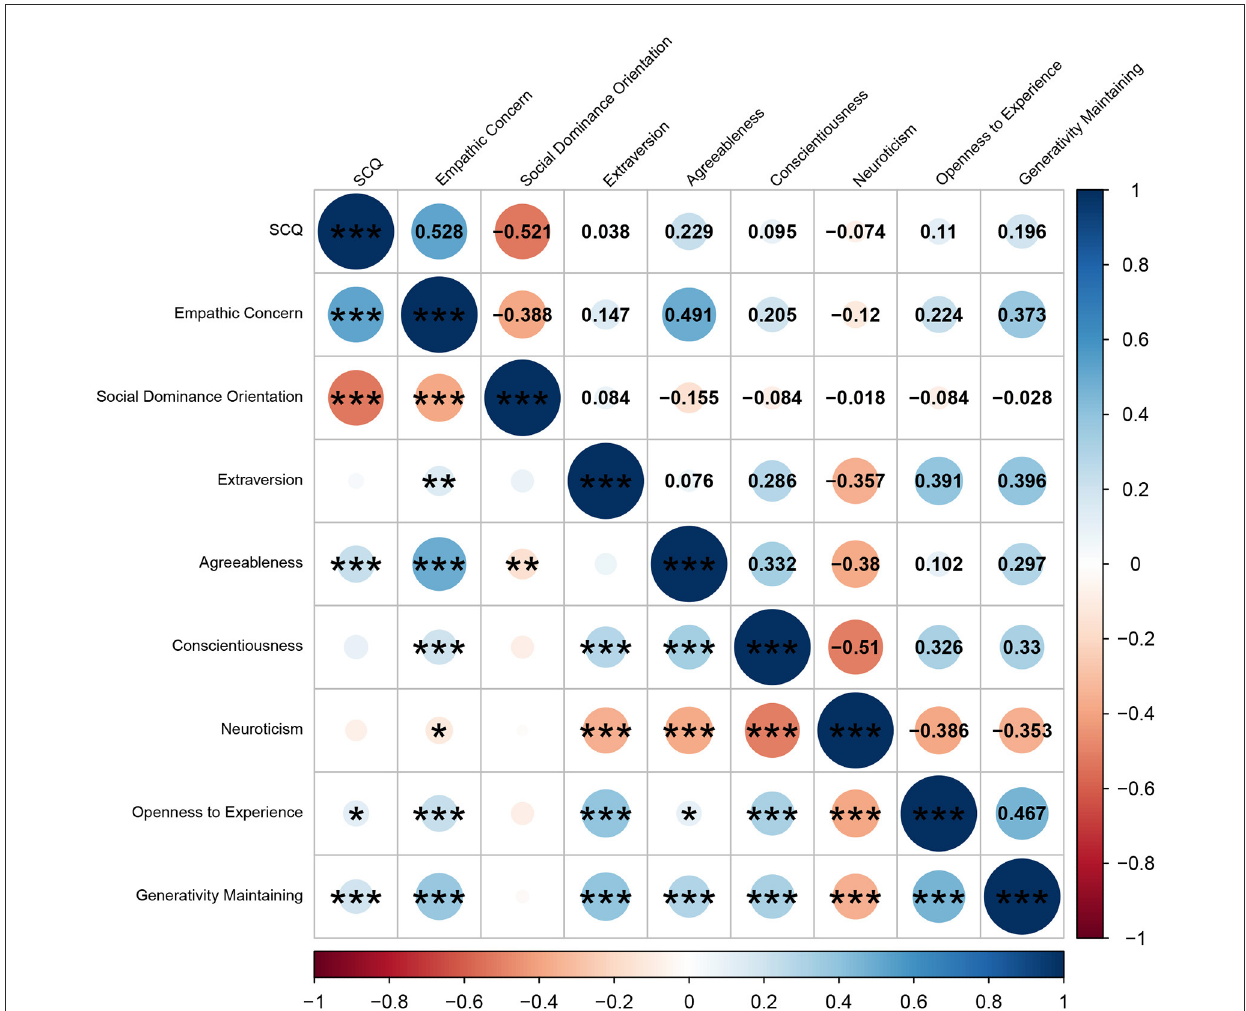
FIGURE7 Correlation matrix between the total score of the sustainability consciousness questionnaire (SCQ) and Climate Change Risk Perception Model scales. Correlation coefficients are shown in the upper triangular matrix and significance values are shown in the lower triangular matrix. The color spectrum indicates the magnitude of the correlation coefficient. For holistic affect regarding climate change, higher scores indicate a more positive evaluation of climate change, while lower scores indicate a more negative evaluation. *** p < 0.001, ** p < 0.01, * p <